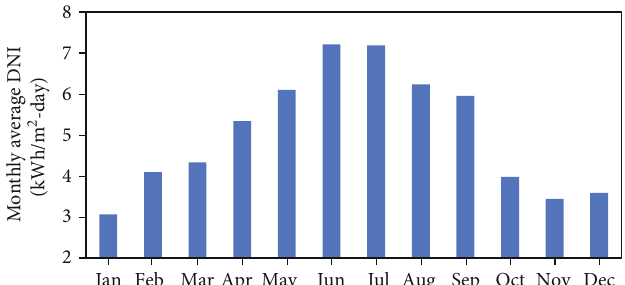
Figure 4: Monthly average direct normal irradiance (DNI) in